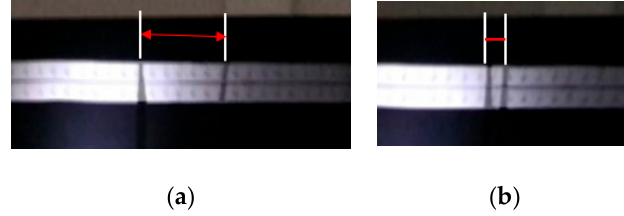
Figure 19. The velocity profiles when moving 425 mm over 0.8 s. Table 5. Experimental results of maximum amplitude and settling time when moving 425 mm over 0.8 s.